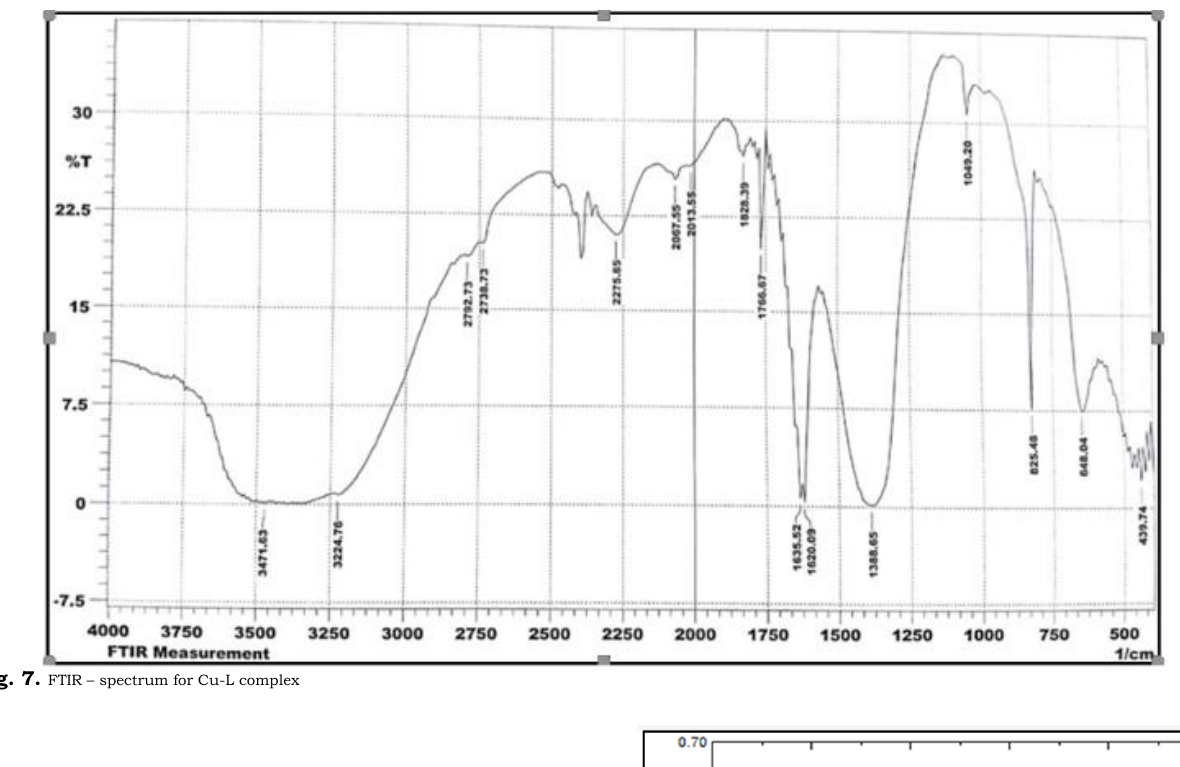
Fig. 7. FTIR – spectrum for Cu-L complex